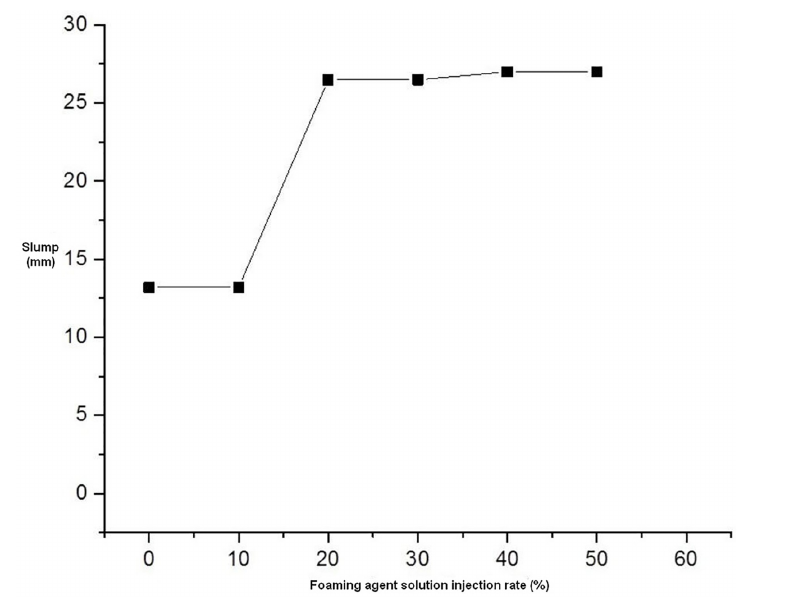
Fig 11. Slumps under different additive injection ratios.